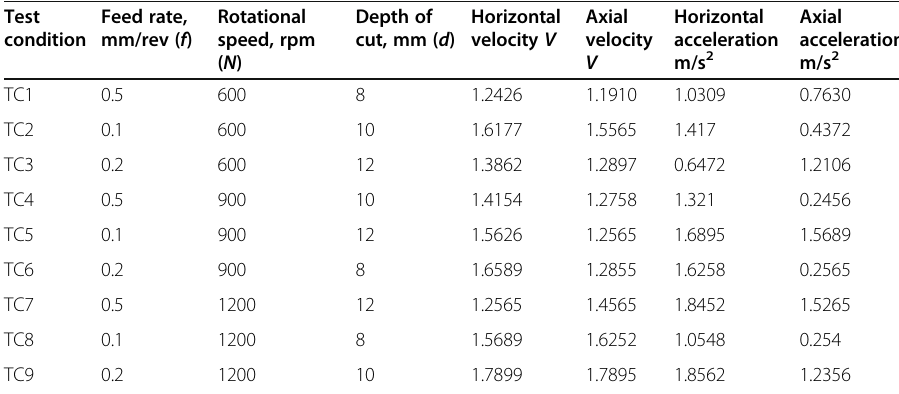
Table 4 Vibrational data of tool B Test Feed rate, condition mm/rev ( f